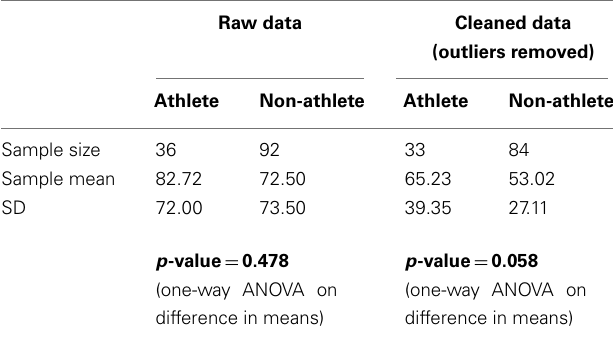
Table 1 | Summary statistics for raw and cleaned